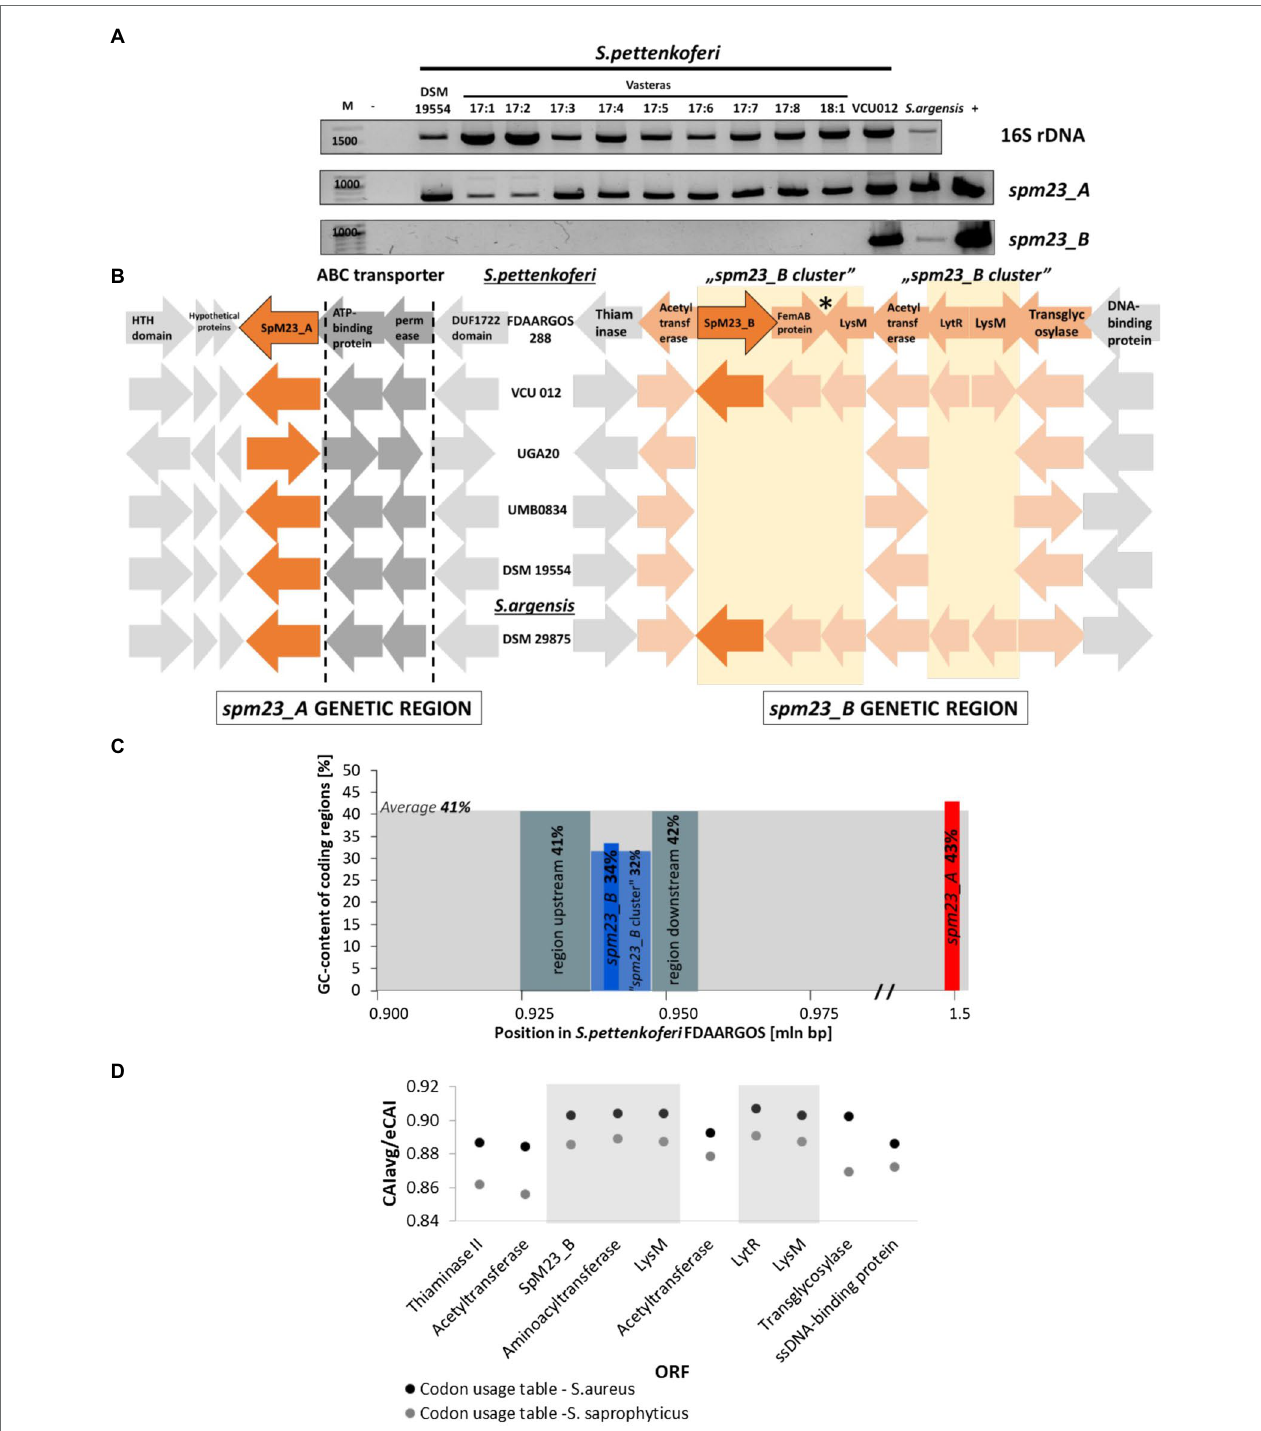
FIGURE 2 | The genetic context of the spm23_A and spm23_B genes. (A) The PCR screening of Staphylococcus pettenkoferi strains for the presence of the spm23_A and spm23_B genes. The reaction targeting the 16S rRNA gene was treated as an internal control of the genome DNA template quality. − , reaction without added DNA; +, reaction with the addition of plasmid encoding each gene. (B) Schematic representation of the genetic neighborhood of the spm23_A and spm23_B genes in the selected strains. The left panel shows the gene arrangement of spm23_A and the right panel the gene arrangement of spm23_B . The pale-yellow square indicates part of the “ spm23_B cluster.” Arrows in shades of orange indicate genes involved in envelope metabolism, an asterisk indicates the site where inverted repeats were identified. The direction of the arrow corresponds to the gene orientation. HTH domain: HTH domain-containing protein; LysM: LysM